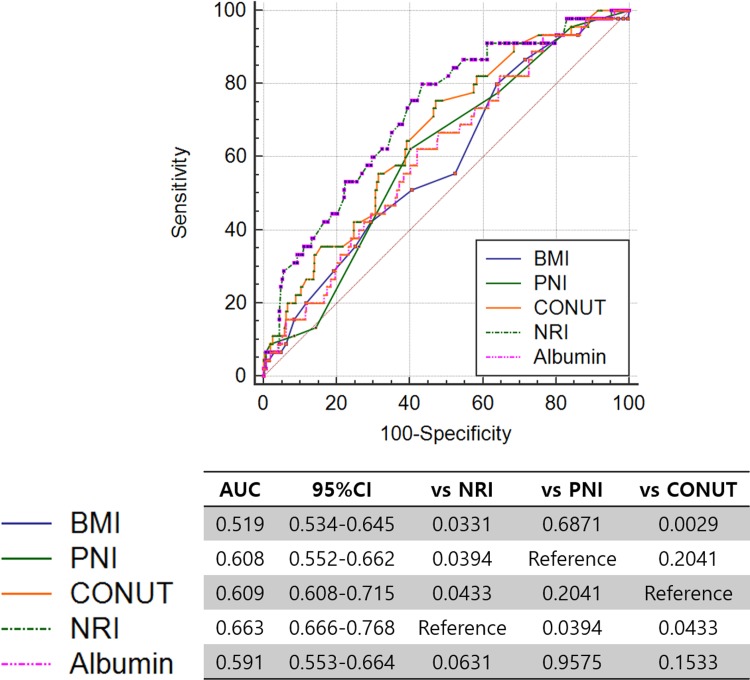
Receiver operating characteristics-curve analysis among variables associated with nutrition.CONUT = COntrolling NUTritional.